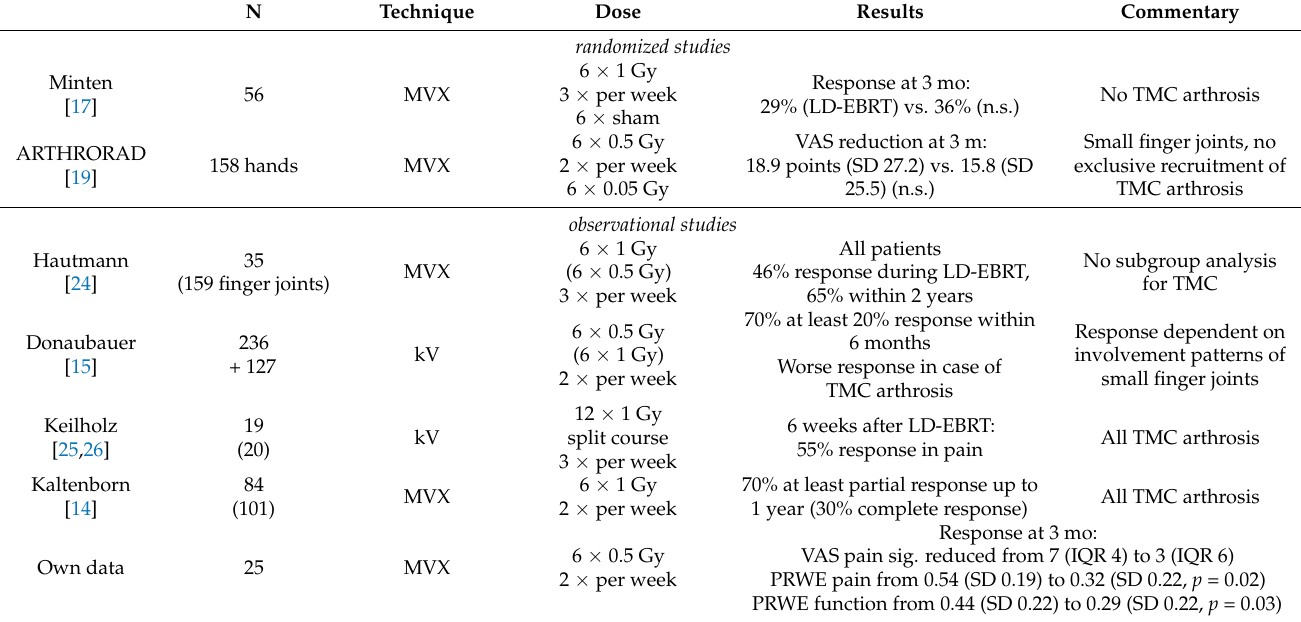
Table 3. Comparison of own data with contemporary studies on LD-EBRT of rhizarthrosis/arthrosis of small finger joints. kV: kilovolts (“X-rays”), MVX: megavolts (“linear accelerator radiation”), LD-EBRT: low-dose external beam